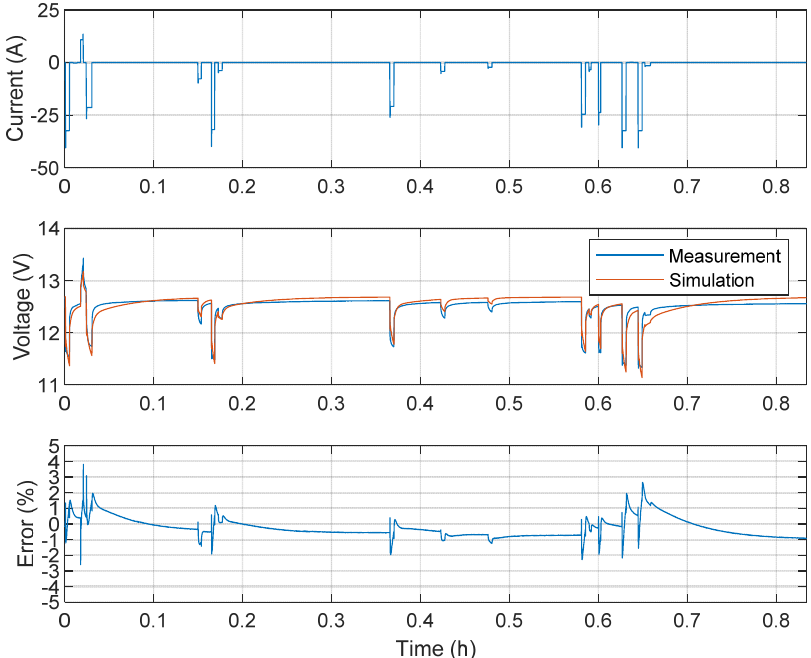
Figure 14. Aged lead-acid battery validation test (40% SOH).